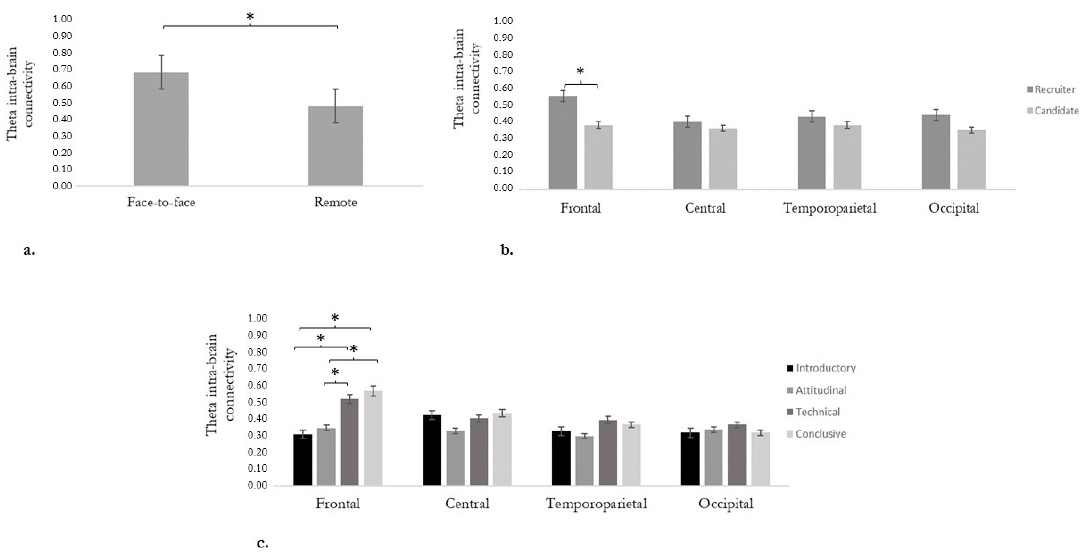
Figure 3. Theta intra-brain connectivity results ( a ) Bar graph shows differences in Condition (ROI). Bars represent ±1 SE. Stars mark statistically significant pairwise comparisons. ( b ) Bar graph shows differences considering Condition*ROI. Bars represent ±1 SE. Stars mark statistically significant pairwise comparisons. ( c ) Bar graph shows differences considering the interaction Inter- view*ROI*Role. Here are reported only candidate’s data where significant differences were de- tected. Bars represent ±1 SE. Stars mark statistically significant pairwise comparisons.